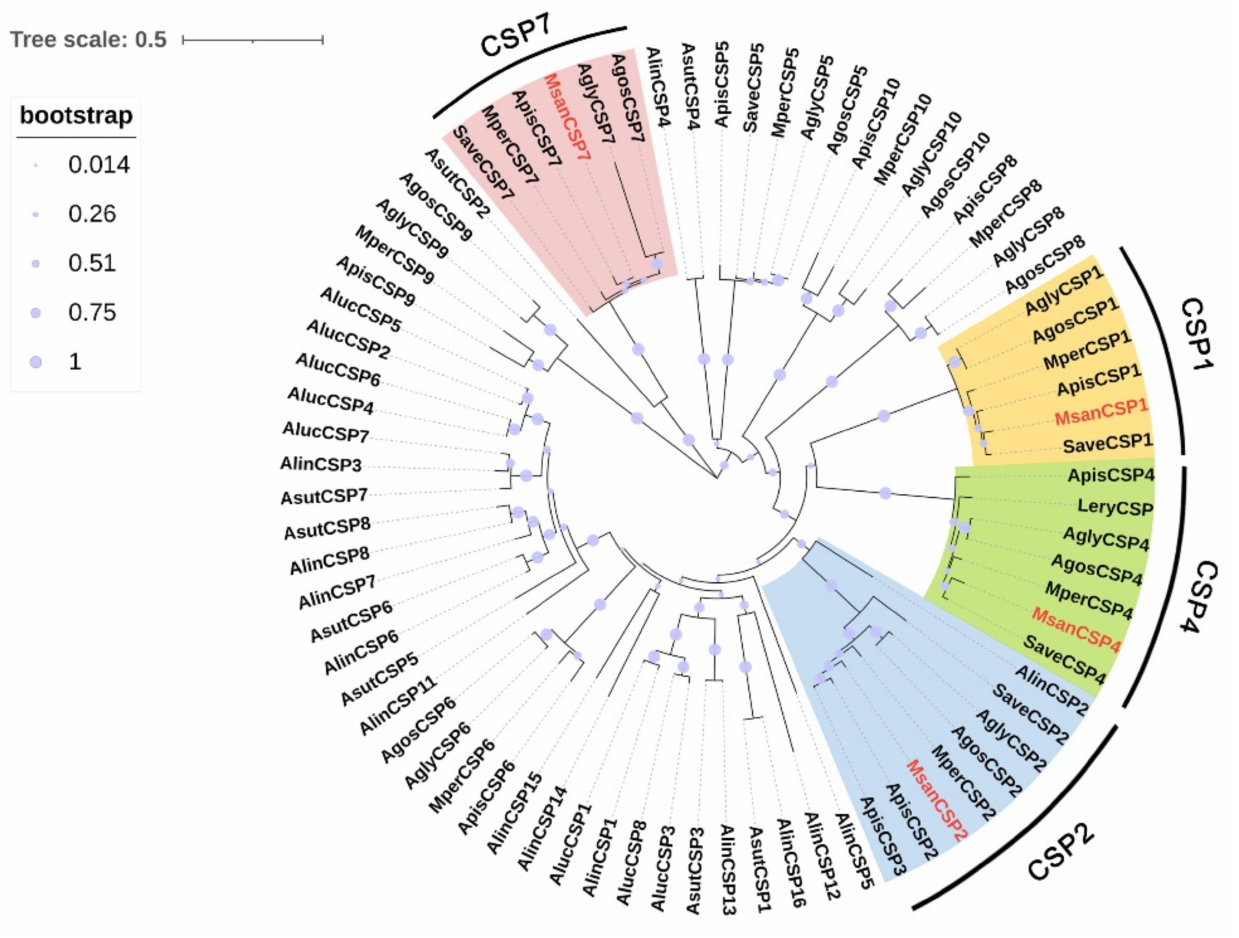
Figure 4. Phylogenetic tree of 77 chemosensory proteins (CSPs) from 10 Hemiptera species. The phylogenetic tree of Hemiptera CSPs was built using 77 CSP sequences from seven different aphid species (9 from My. persicae ; 9 from A. gossypii ; 10 from Ac. pisum ; 9 from A. glycines ; 5 from S. avenae ; 1 from L. erysimi ; 4 from M. sanborni ) and three plant bugs (8 from Ad. suturalis ; 14 from Ad. lineolatus ; 8 from Ap. lucorum